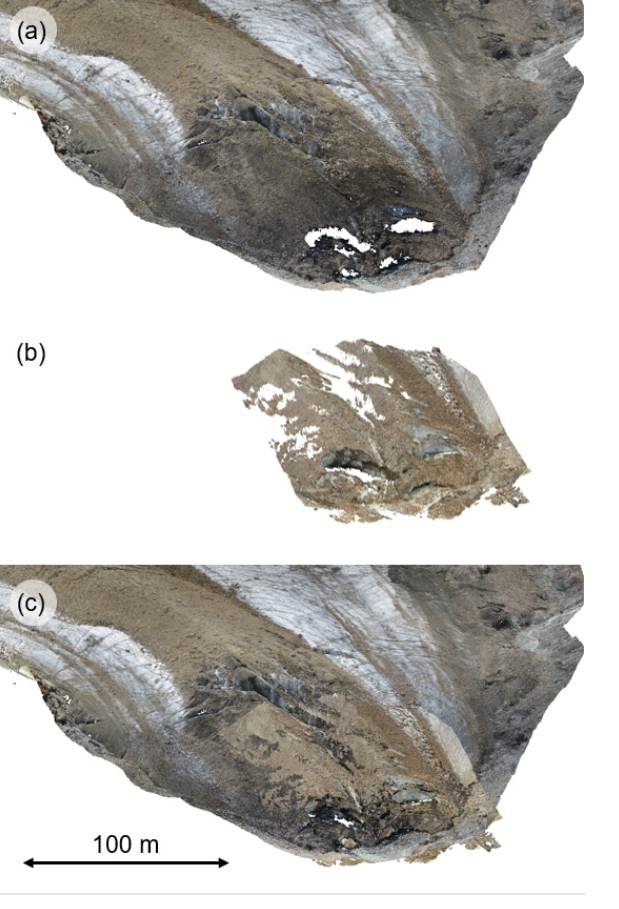
Figure 6. Spatial coverage of UAV and terrestrial photogramme- try point clouds and merged point cloud from the two techniques. (a) UAV photogrammetry point cloud; (b) terrestrial photogramme- try point cloud; (c) merged point cloud.